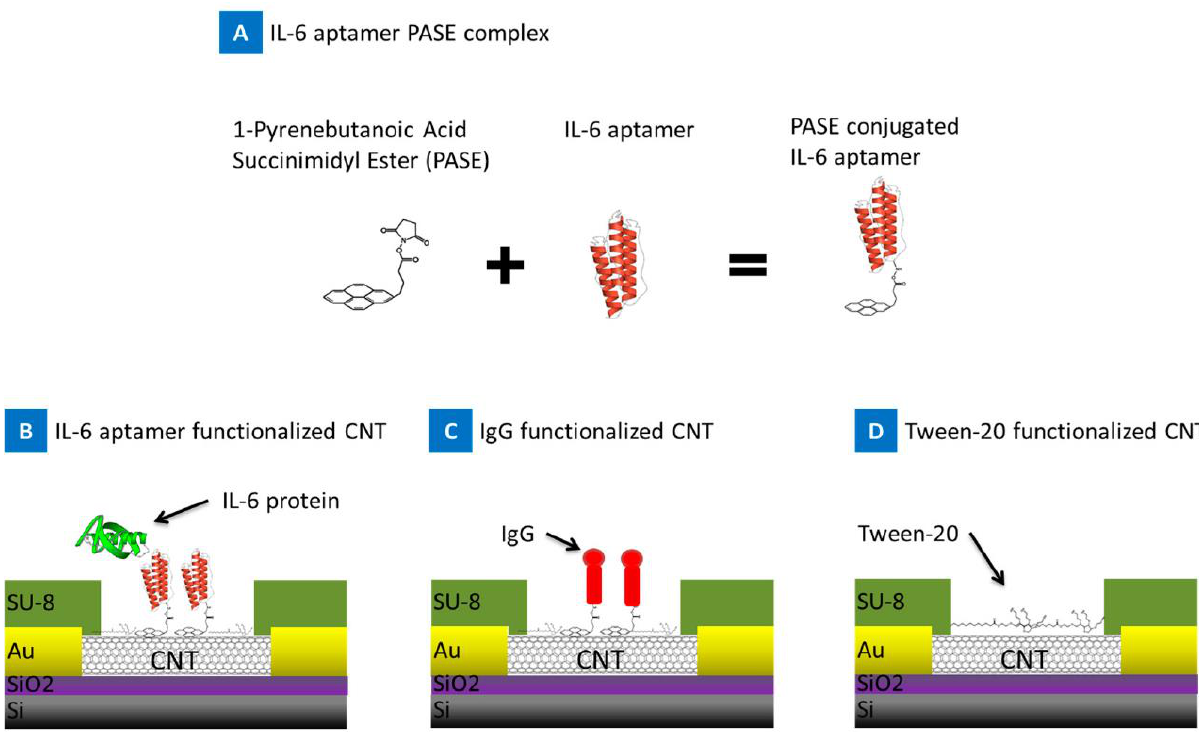
Figure 15. ( A ) Schematic illustration depicting the reaction of 1-pyrenebutanoic acid succinimidyl ester (PASE) with IL-6 Apt forming the IL-6 aptamer PASE complex. Schematic illustrations of the CNT FET sensor functionalized with ( B ) IL-6 Apt PASE complex as positive control, ( C ) IgG as a negative control and ( D ) tween-20 blocking agent as a negative control. Reprinted from [100] with permission from MDPI.